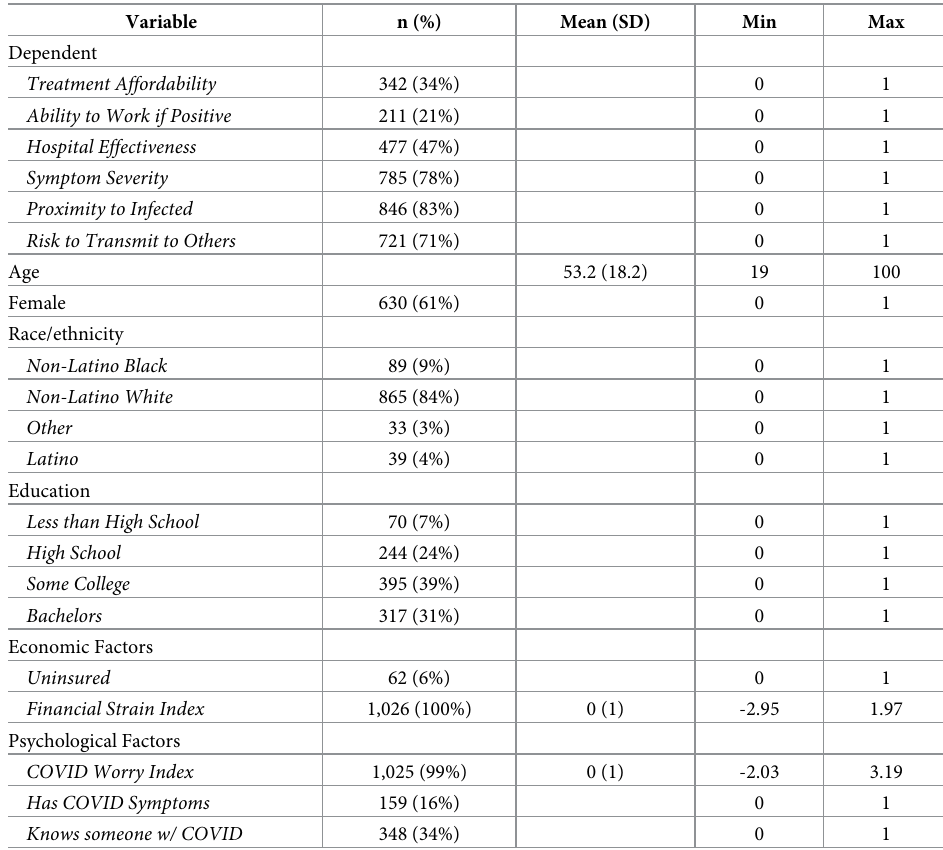
Table 1. Descriptive